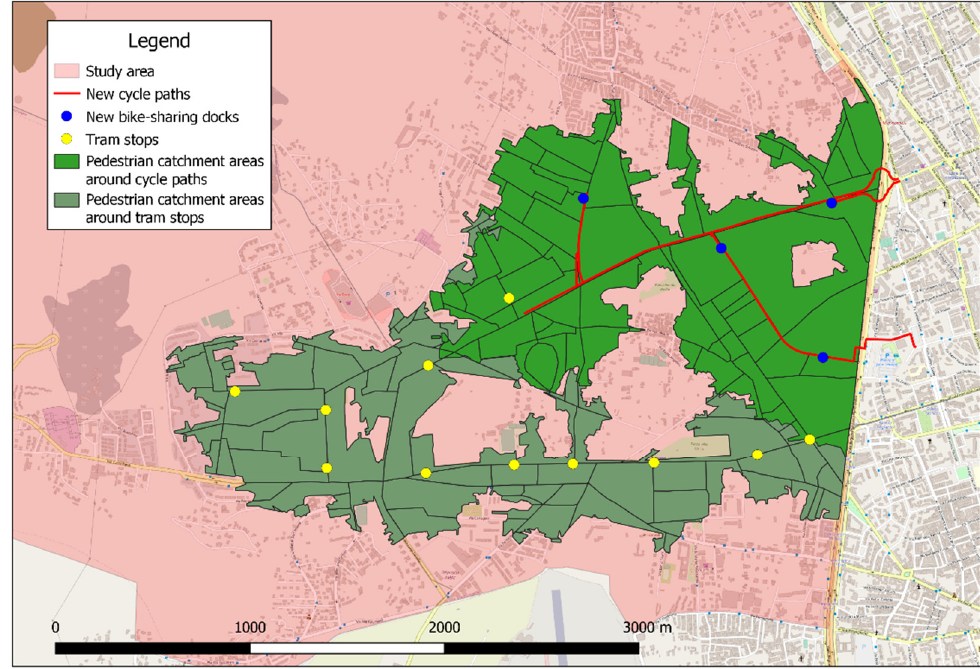
Figure 7. The pedestrian catchment areas around the new cycle paths and the tram stops in the study area.